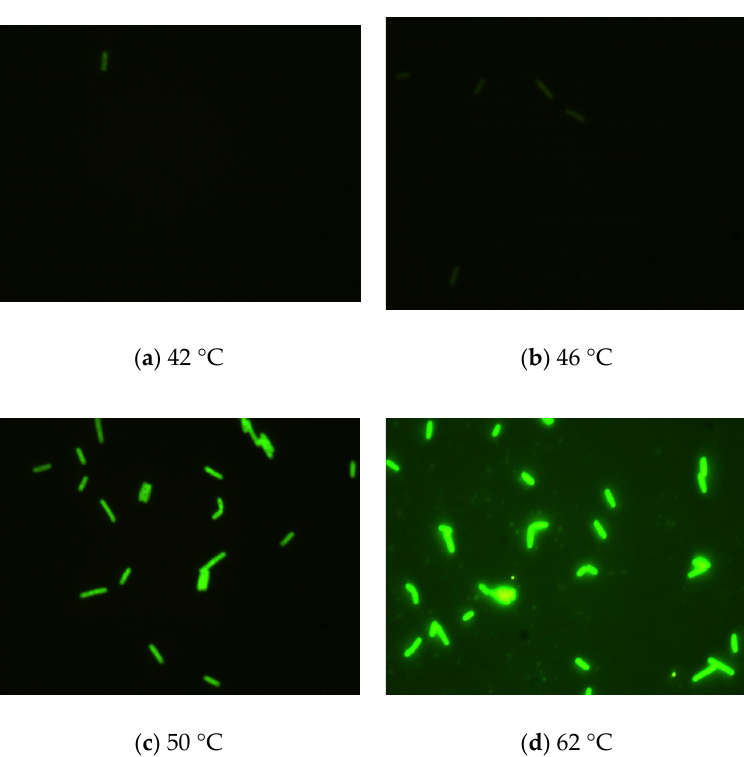
Figure 2. Identification of the optimal hybridization temperature for detecting K. pneumoniae using FISH. ( a – d ) K. pneumoniae cells were detected by FISH with specific probes at different hybridization temperatures ( a : 42 °C, b : 46 °C, c : 50 °C, and d : 62 °C) for 1.5 h.